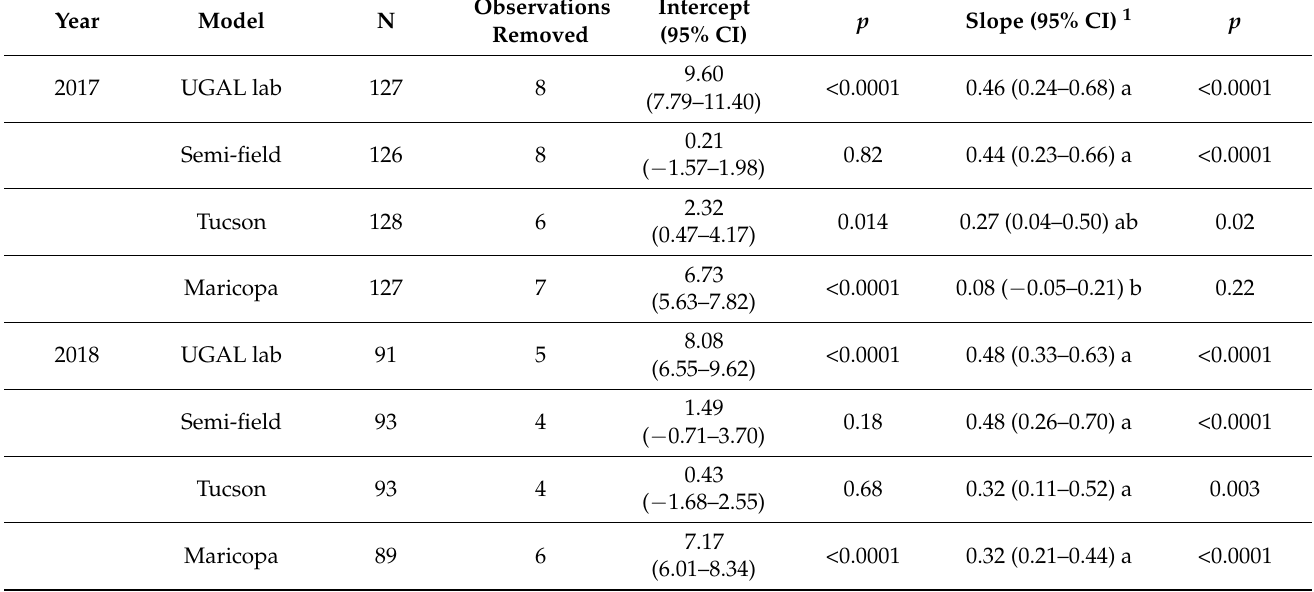
Table 2. Linear associations between age predicted by SCP1 analyses and the four NIRS models in 2017 and 2018. Data points with Studentized residuals > |2| were removed before estimating intercepts, slopes and their associated 95% confidence intervals (see Figure 5). N is the number of observations used to fit simple linear regression models. 1 For each year, the slopes with different letter had non-overlapping 95% confidence intervals and are considered statistically different ( p <